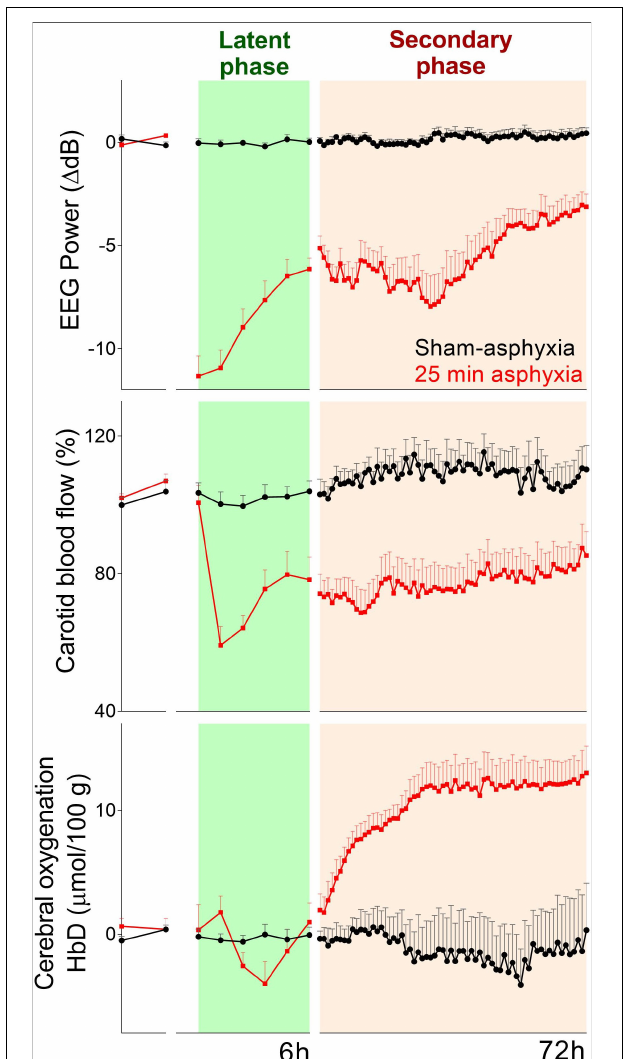
FIGURE 2 | Changes in EEG power (top panel), carotid blood flow (index of cerebral perfusion) (middle panel), and cerebral oxygenation (bottom panel) during baseline and 72 h of post-HI recovery in preterm (0.7 gestation) fetal sheep subjected to sham occlusion ( n = 4) or 25 min of asphyxia ( n = 8). Hypoperfusion during the latent phase was associated with a transient decrease in cerebral oxygenation. Despite the sustained reduction in cerebral blood flow, there was an increase in cerebral oxygenation during the secondary